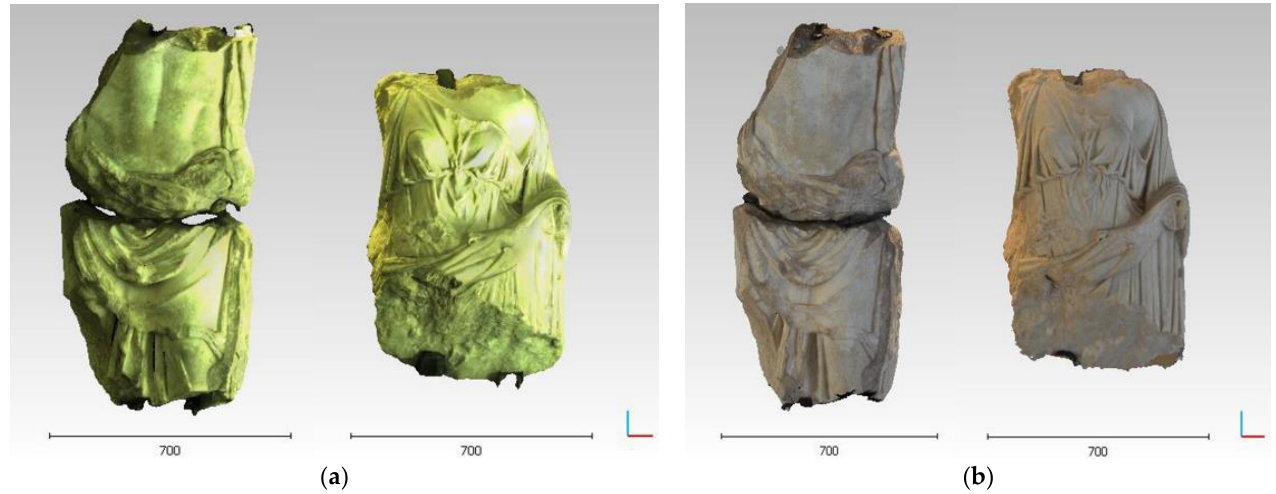
Figure 8. Three-dimensional models of the Aesculapius and Hygeia statues carried out by means of Stonex F6 3D handheld laser scanner ( a ) and photogrammetric survey ( b ).